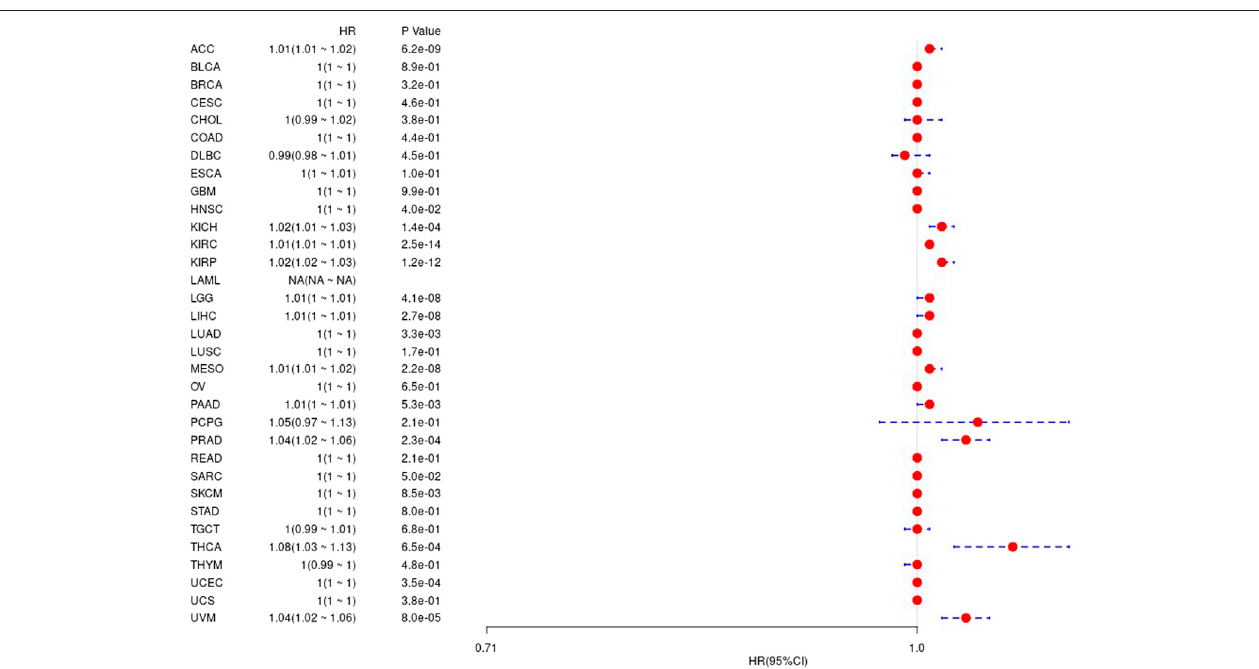
FIGURE 5 | The relationship between UBE2C gene and disease-speci fi c survival in TCGA tumor and nontumor.